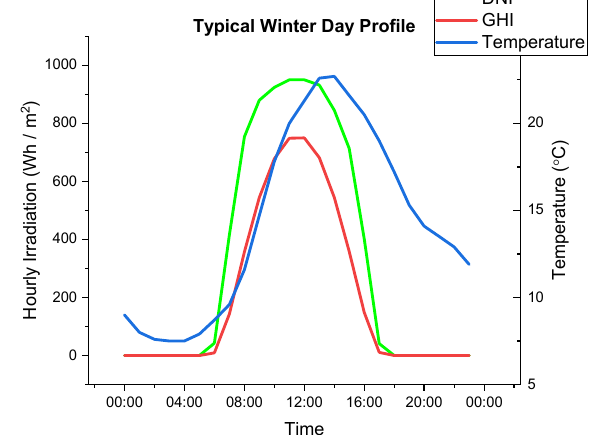
Figure 3. Typical Winter Day Profile.